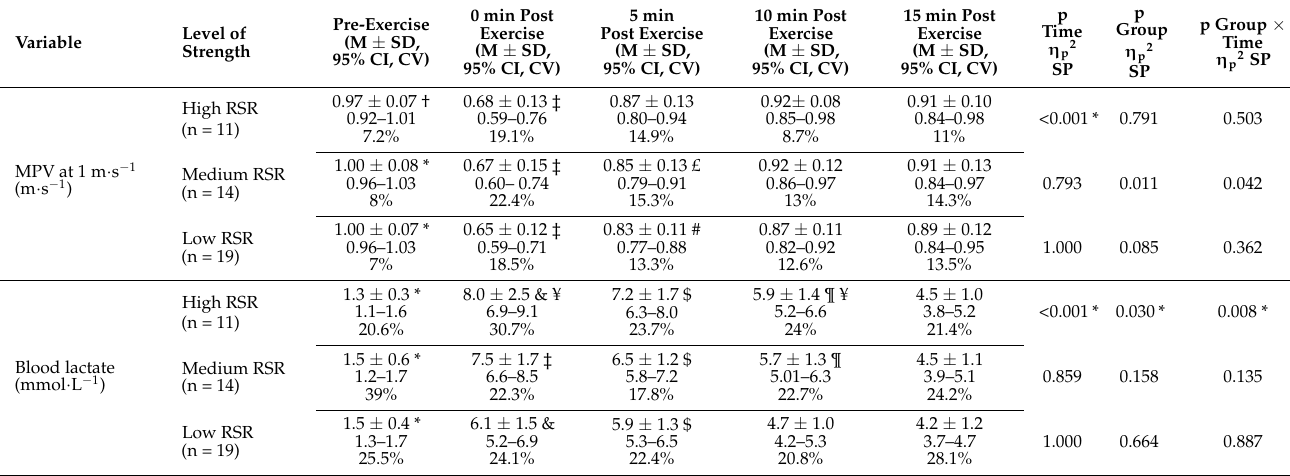
Table 1. Data related to MPV at 1 m · s − 1 and blood lactate concentrations before and after the bench press exercise protocol with a load of 70% MPV obtained in the 1RM test for each individual.